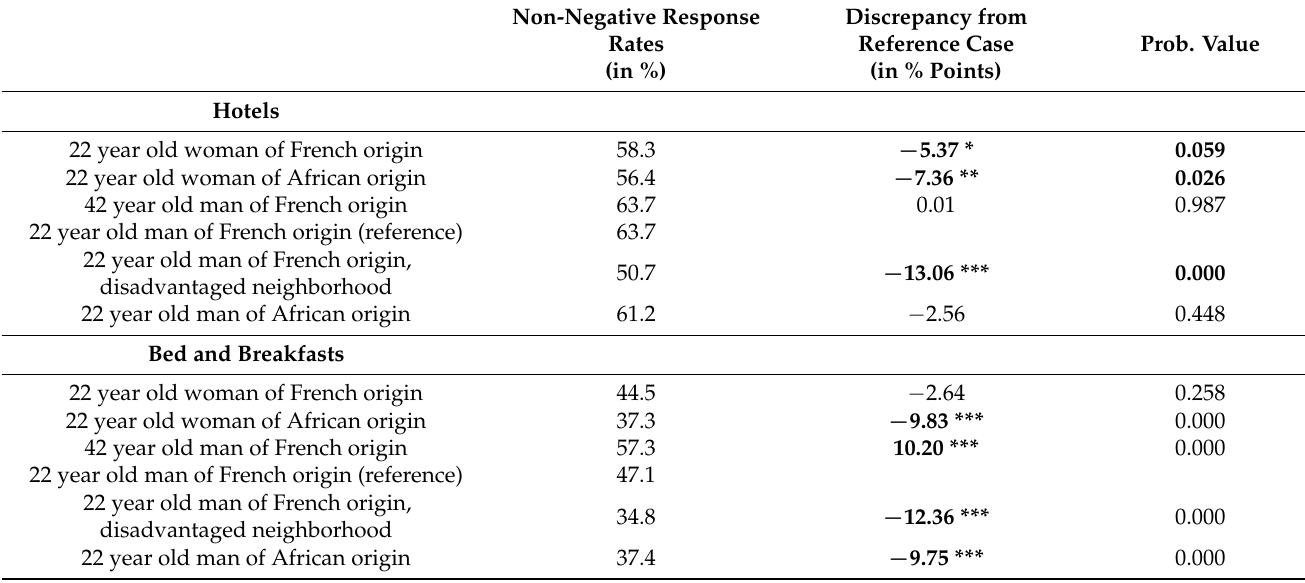
Table A4. Non-Negative Response Rates for the 6 fictional individuals by the type of Lodging (hotel, Bed and Breakfasts,